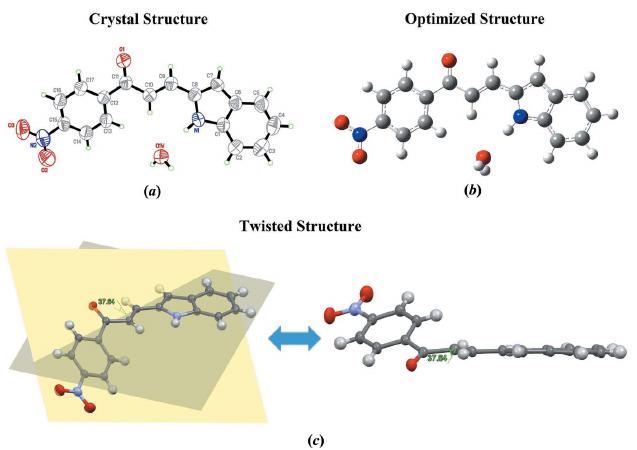
Figure 1 ( a ) The molecular structure of the title compound showing 50% probability ellipsoids, ( b ) the optimized molecular structure and ( c ) a representation of the molecule showing the dihedral angle between the two chosen